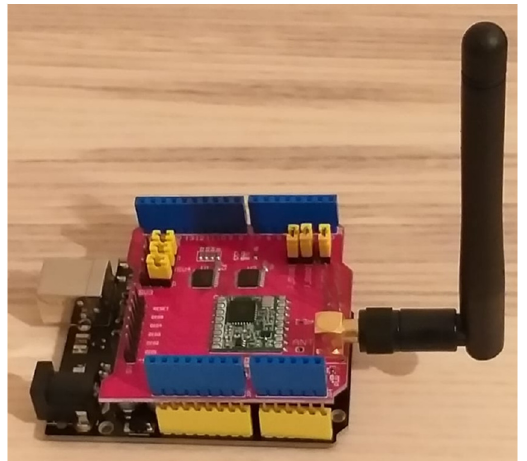
Figure 8. LoRa Node components.